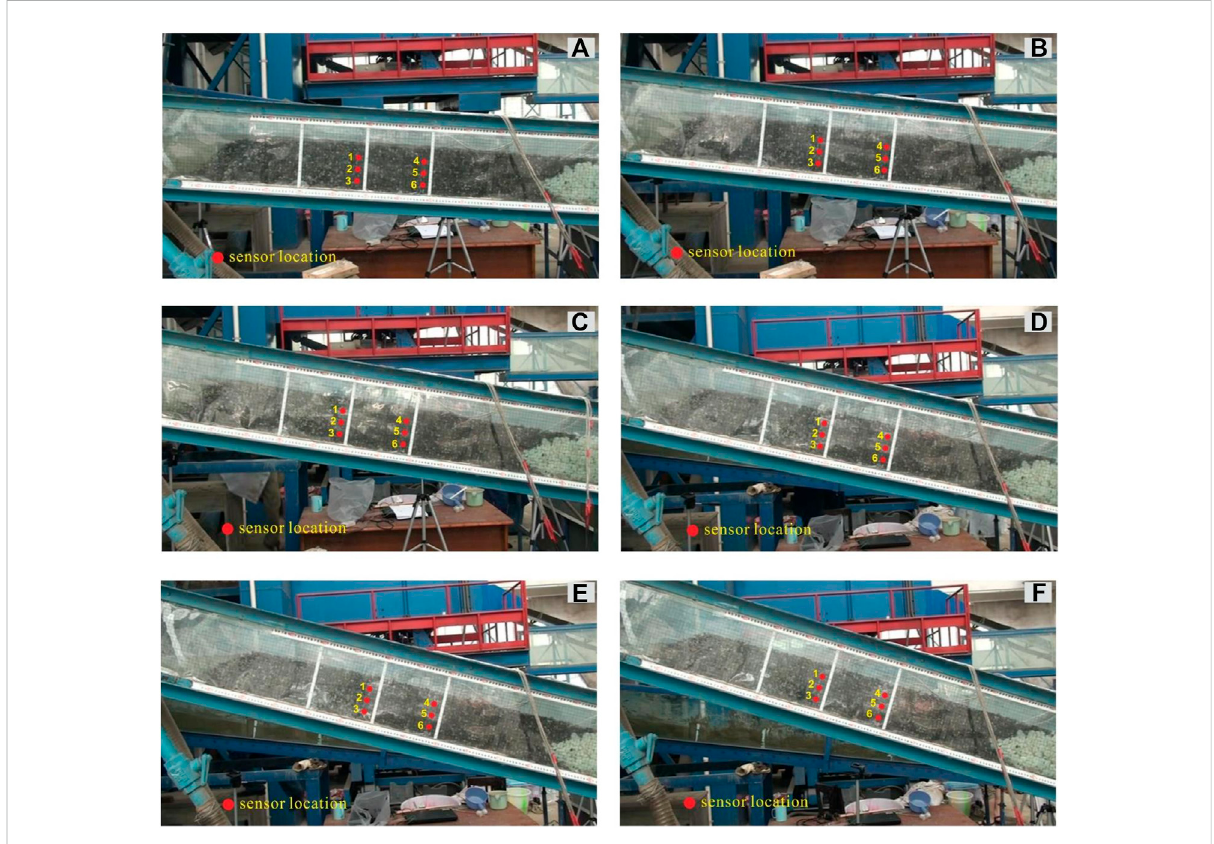
FIGURE 6 The fl ow regime under different slope angles (A) 6 ° , (B) 9 ° , (C) 12 ° , (D) 15 ° , (E) 18 ° , and (F) 20 ° ; the red dots indicate the sensor locations in the center longitudinal